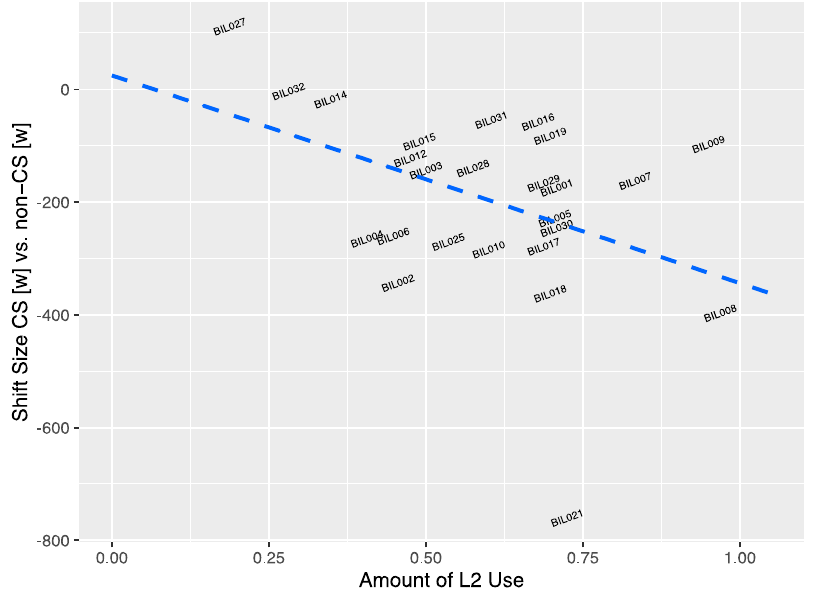
Figure 5. The shift size of CS [w] vs. non-CS [w] as a function of the predictor variable amount of L2 use . Regression line superimposed.